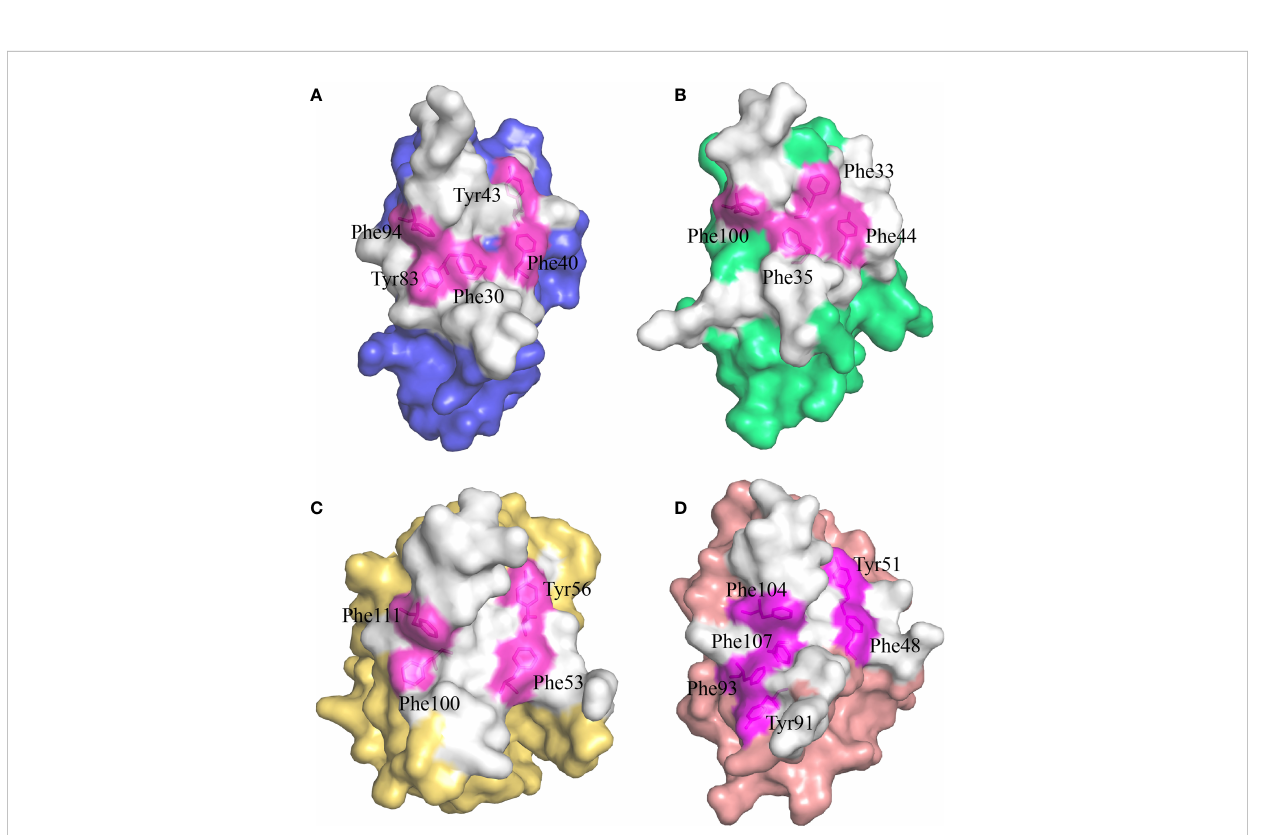
FIGURE 5 The hydrophobic core of the CD8 aa homodimer in small-spotted catshark compared to other vertebrate species. The surface of each CD8 a monomer is rendered in a different color while residues forming the hydrophobic core are shown in stick representation and surface rendered in magenta. (A) The hydrophobic core of Sc CD8 aa is formed by fi ve hydrophobic residues (Phe30, Tyr43, Phe40, Tyr83 and Phe94). (B) The hydrophobic core of grass carp CD8 aa is formed by four hydrophobic residues (Phe32, Phe35, Tyr44, and Phe100). (C) The hydrophobic core of chicken CD8 aa is formed by four hydrophobic residues (Phe53, Tyr56, Phe100, and Phe111). (D) The hydrophobic core of human CD8 aa is formed by six hydrophobic residues (Phe48, Tyr51, Tyr91, Phe93, Phe104 and